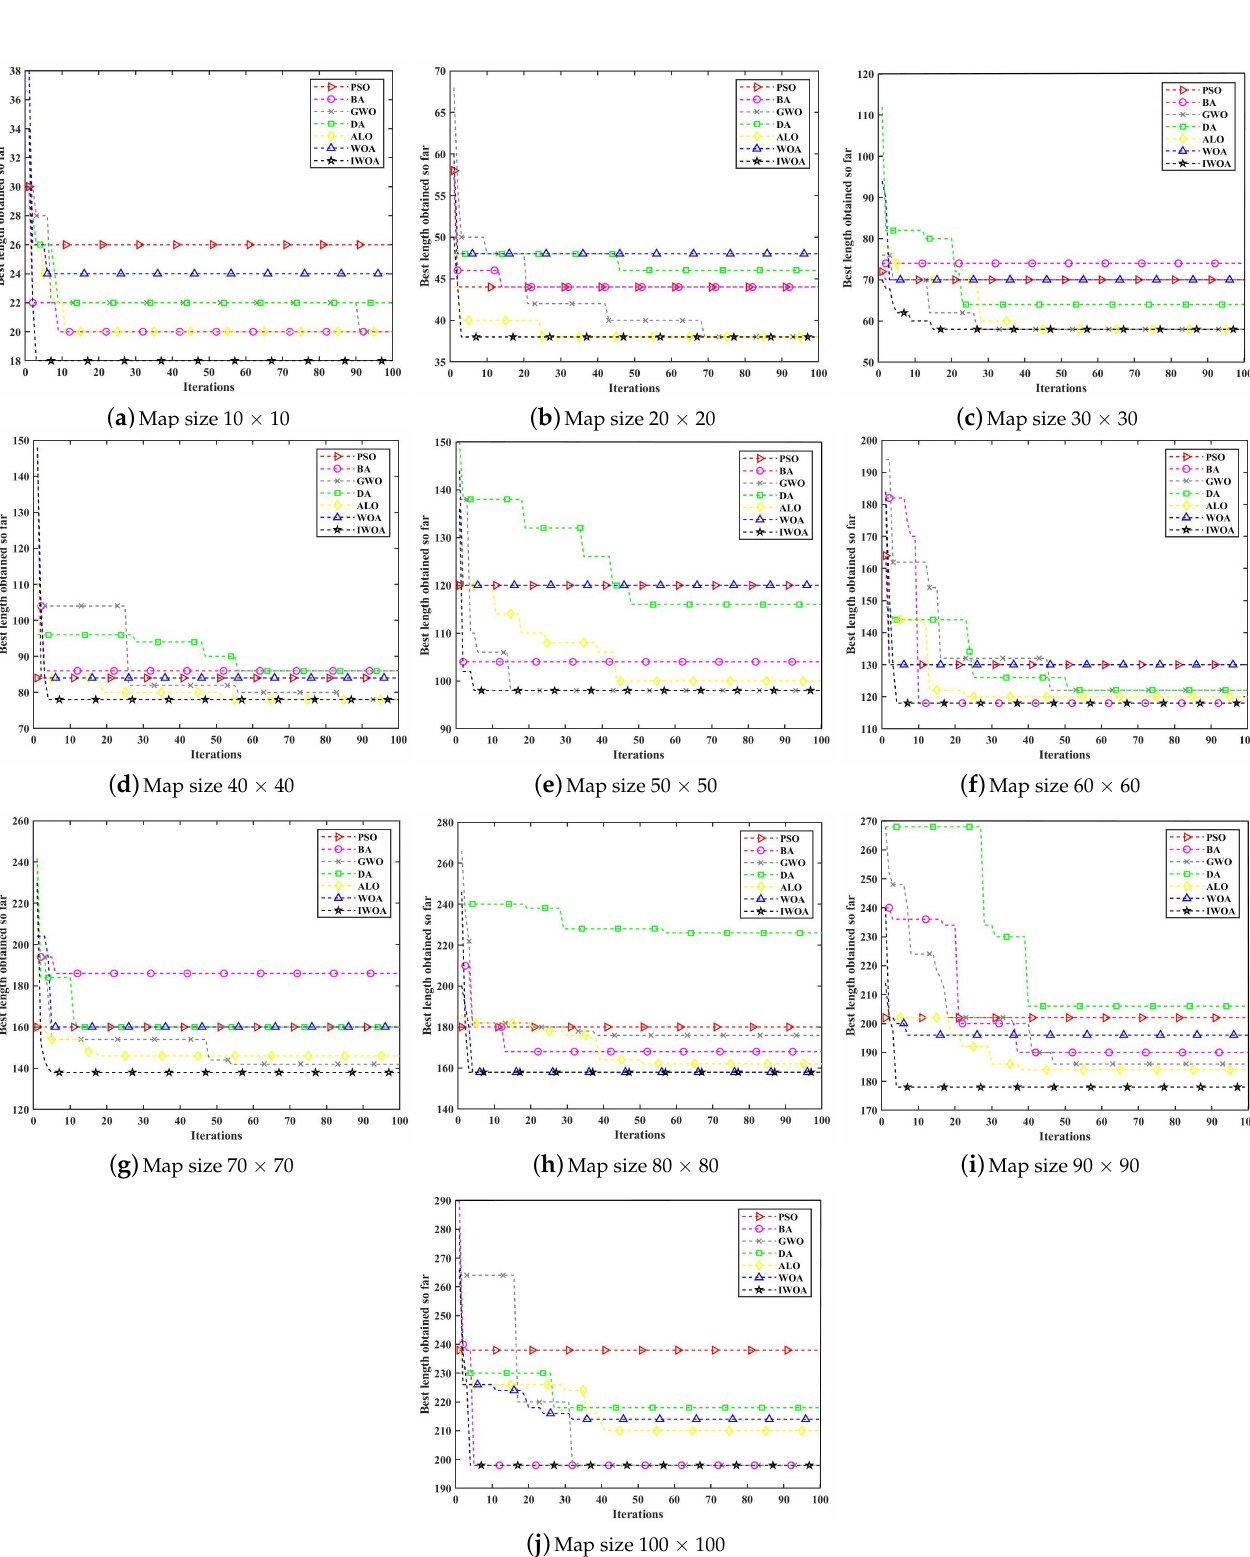
Figure 10. Different algorithms solve different size maps, and the solution value changes with the number of